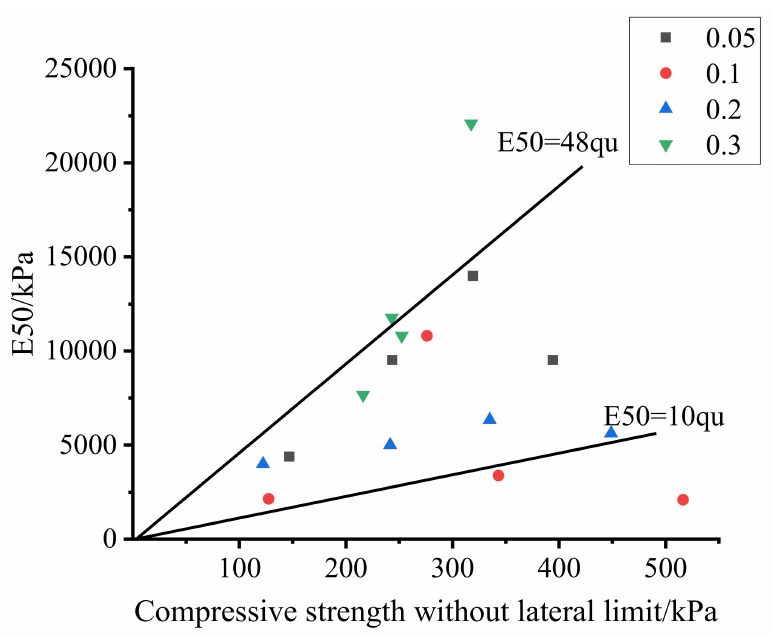
Figure 6. Relationship between modulus of deformation and unconfined compressive